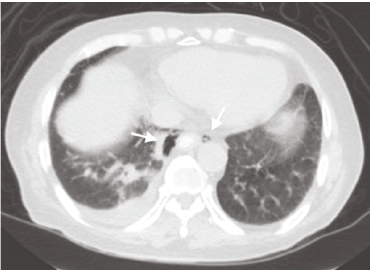
Figure 5: CT scan of thorax illustrating presence of pneumomedi- astinum at the level of the